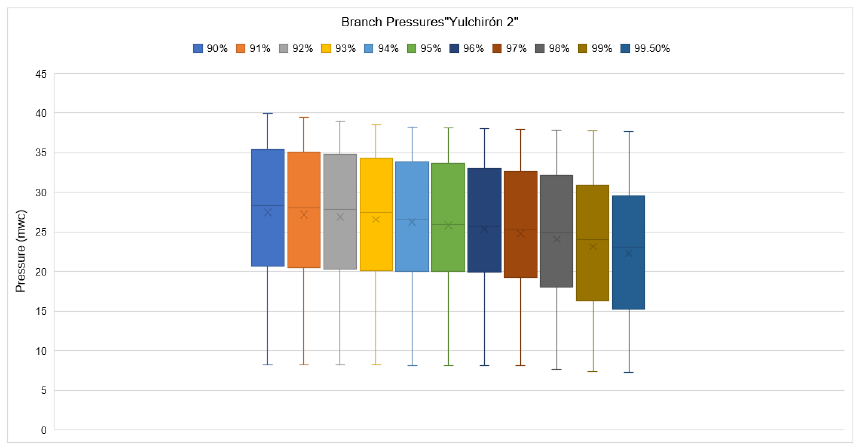
Figure 12. Yulchirón 2 branch pressures operating at demand, scenario 1. Figure 12. Yulchir ó n 2 branch pressures operating at demand, scenario